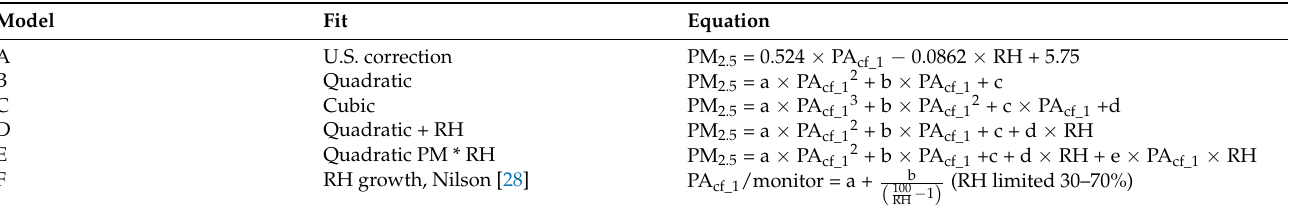
Figure 1. Nonlinearity in hourly PurpleAir PM 2.5 , uncorrected [cf = 1], versus the monitor PM 2.5 values, colored by the relative humidity, as measured by the PurpleAir. Table 3. Correction equations that were considered.